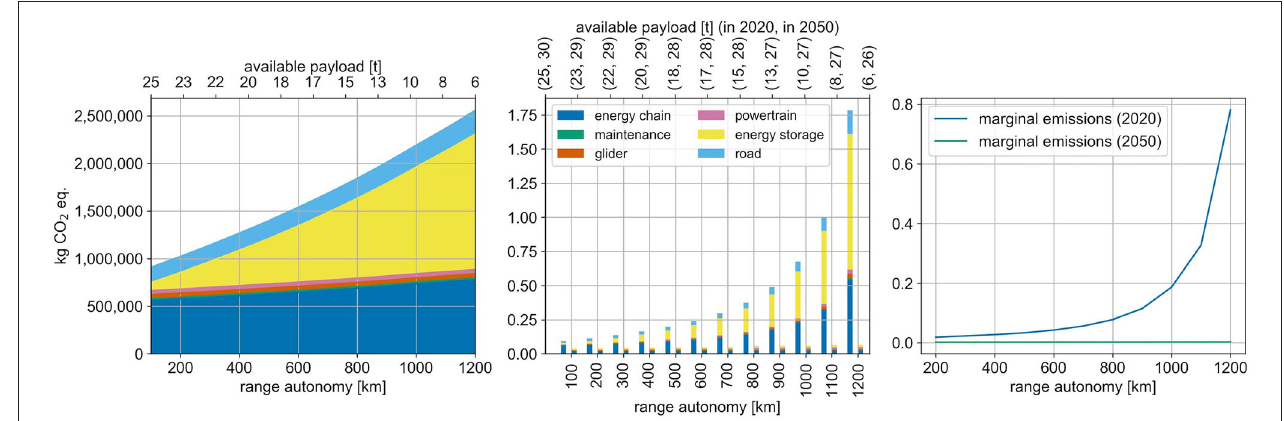
FIGURE 5 | Upscaling scenarios for a 40-ton battery electric truck Left: Total Global Warming impact in kg CO 2 -eq as a function of vehicle range autonomy in 2020. Center: Global Warming impact in kg CO 2 -eq/tkm as a function of vehicle range autonomy in 2020 and 2050. Right: marginal Global Warming impact in kg CO 2 -eq/tkm as a function of vehicle range autonomy in 2020 and 2050.